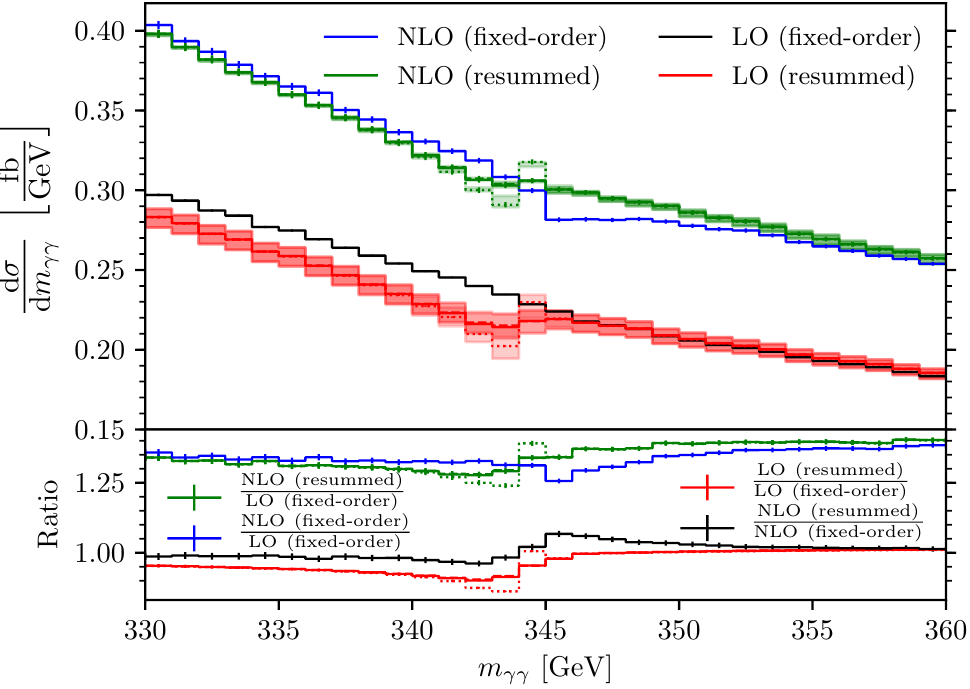
Figure 6. E(cid:11)ect of the top quark width on the dip-bump-structure at LO and NLO. The solid lines correspond to (cid:0) t = 1 : 367 GeV, the dashed to (cid:0) t = 1 : 498 GeV and the dotted to (cid:0) t = 0 : 5 GeV. The corresponding scale bands are also shown in the upper